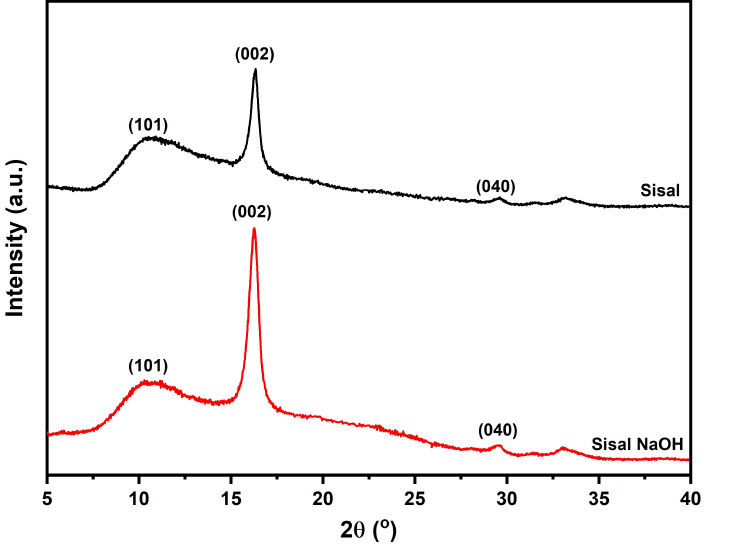
Figure 3. X-ray diffractogram of Sisal and Sisal NaOH.